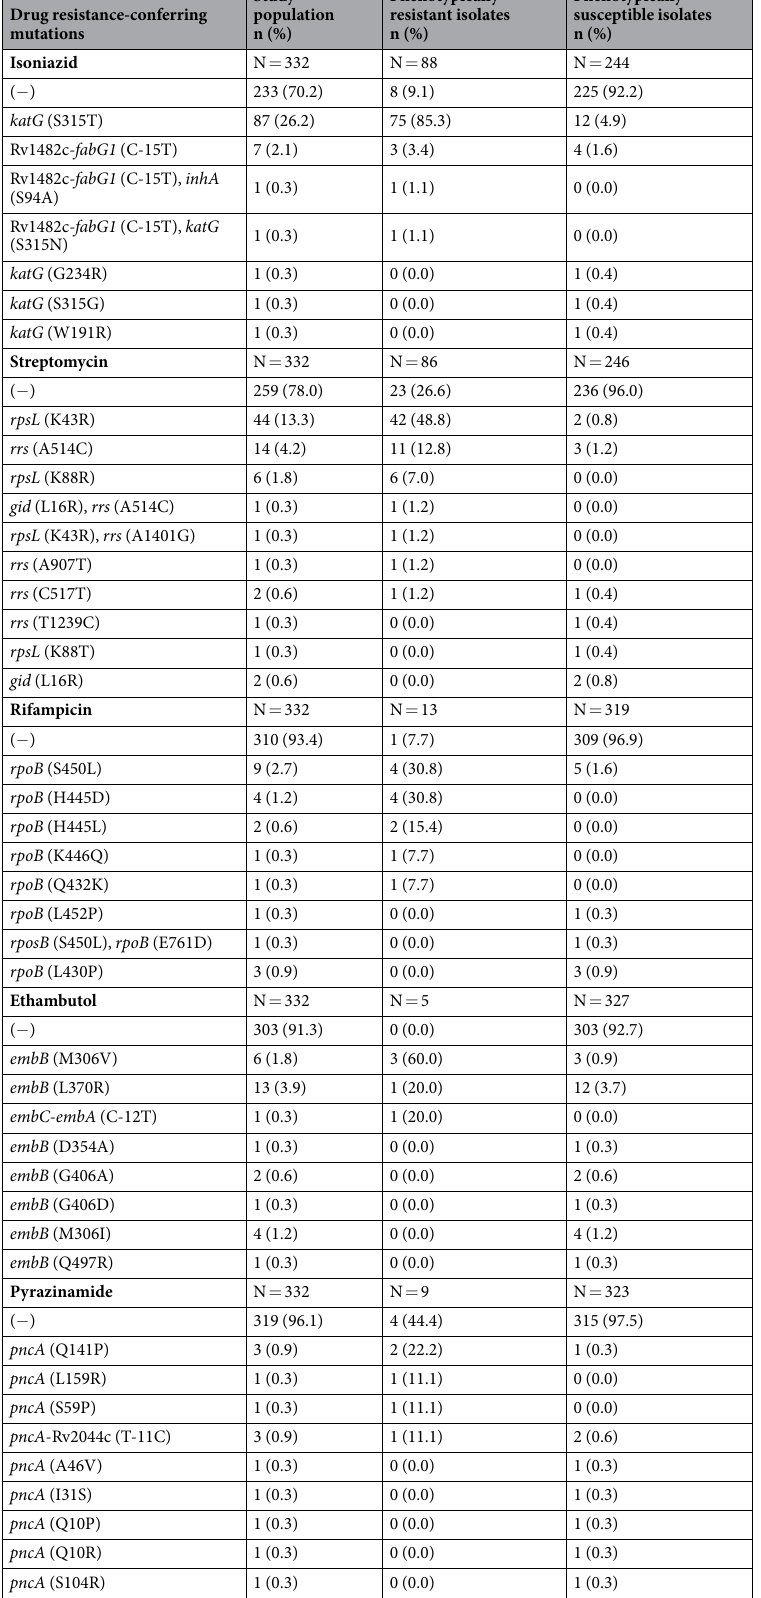
Table 1. Frequencies of known mutations conferring resistance to first-line drugs among all isolates, phenotypically resistant isolates, and susceptible isolates in the Hanoi sample set (N =